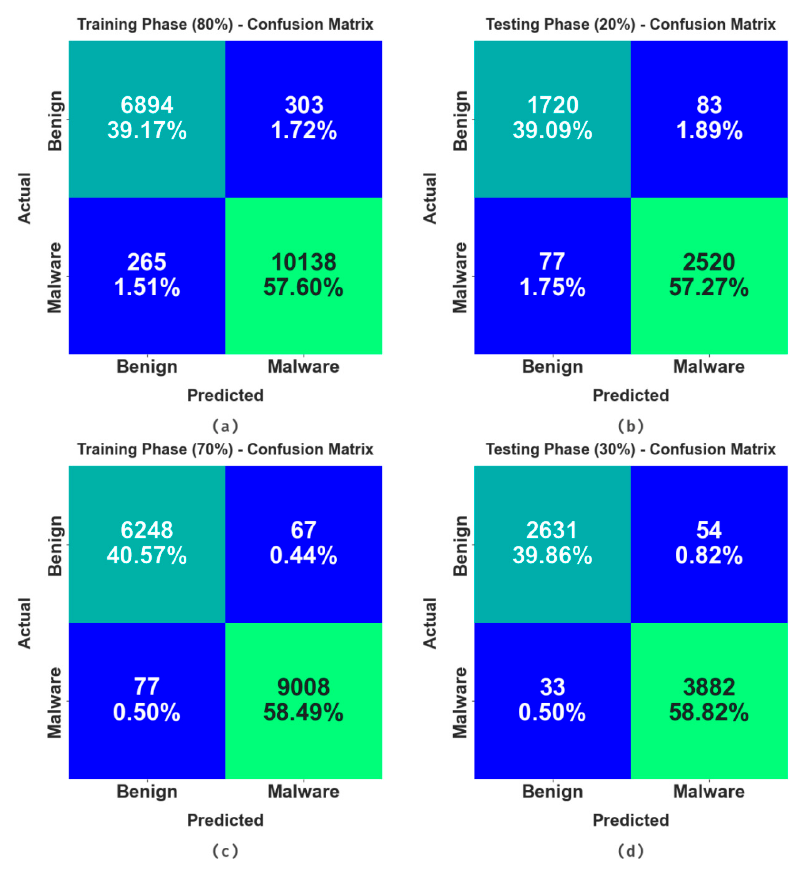
Figure 4. Confusion matrices of the RHSODL-AMD algorithm ( a , b ) TRS/TSS of 80:20 and ( c , d ) TRS/TSS of 70:30.